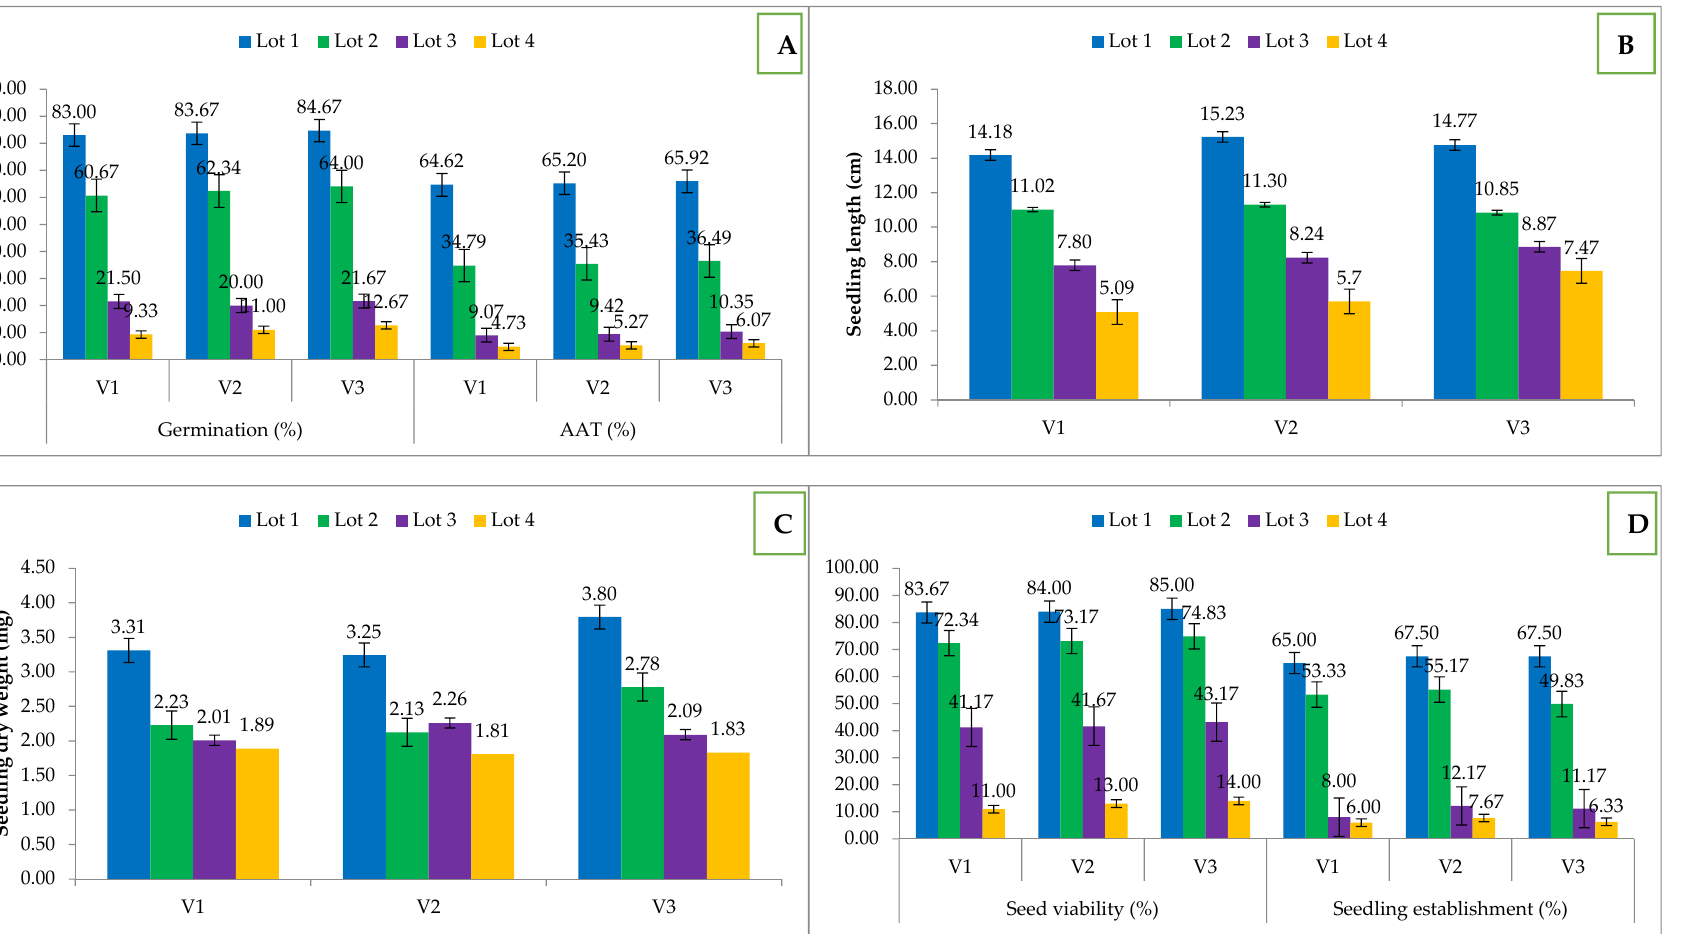
Figure 1. Effect of seed ageing on ( A ) germination and accelerated ageing test (AAT); ( B ) seedling length; ( C ) seedling dry weight; ( D ) seed viability and seedling establishment; V 1 —Hisar-2; V 2 —Hisar Onion 3; V 3 —Hisar Onion 4; Lot 1—Fresh seed; Lot 2—One-year-old seed; Lot 3—Two-year-old seed; Lot 4—Three-year-old seed.